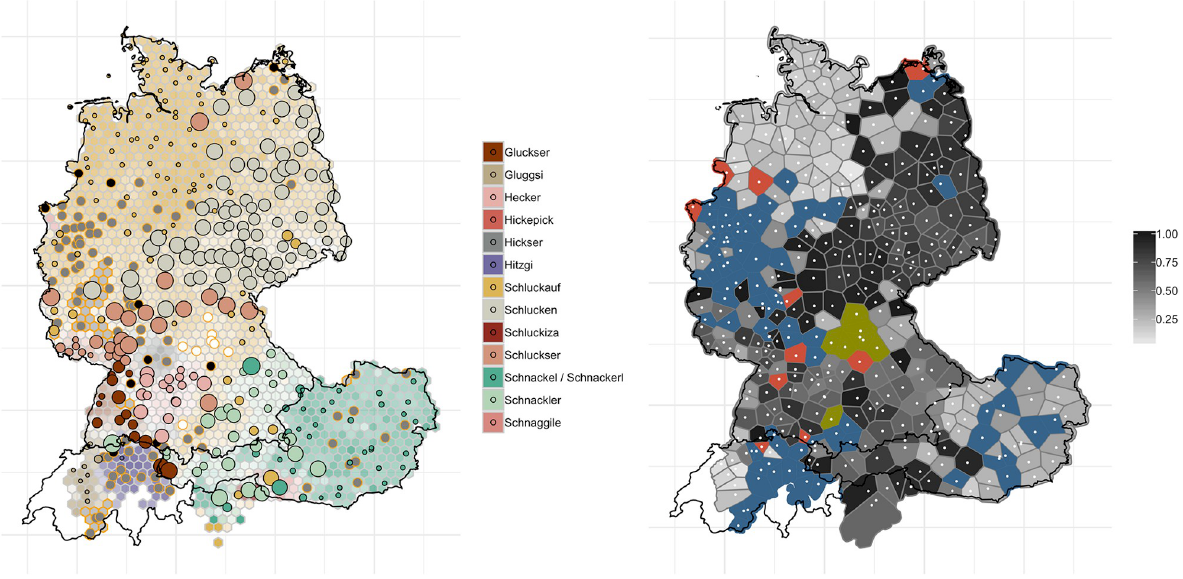
Fig 12. Variant and degree of change maps for